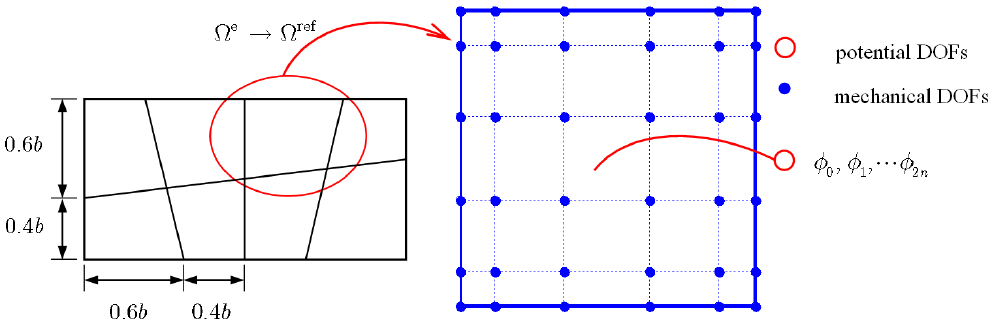
Figure 2. Discretization of a plate and an example of spectral